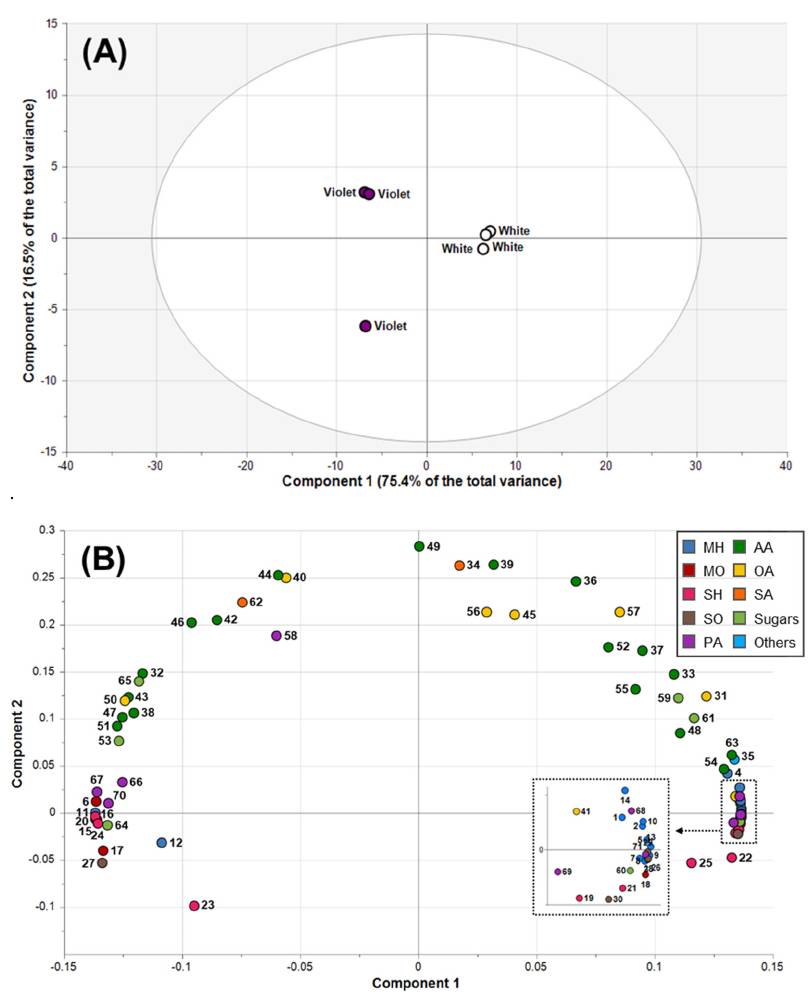
Figure 1. Score plots ( A ) and loading plots ( B ) of principal components 1 and 2 for the principal component analysis of essential oils, phenolic acids, and hydrophilic metabolites measured from M. heptapeta (white) and M. denudata var. purpurascens (violet) flower buds. MH, monoterpene hydrocarbons; MO, oxygenated monoterpene; SH, sesquiterpene hydrocarbons; SO, oxygenated sesquiterpene; PA, phenolic acids; AA, amino acids; OA, organic acids; SA, sugar alcohols. Plot annotations: 1, α -thujene; 2, α -pinene; 3, camphene; 4, sabinene; 5, β -pinene; 6, β -myrcene; 7, α -phellandrene; 8, δ -3-carene; 9, α -terpinene; 10, limonene; 11, 1,8-cineole; 12, ( Z )- β -ocimene; 13, γ -terpinene; 14, α -terpinolene; 15, camphor; 16, 3-cyclohexen-1-ol; 17, 3-cyclohexene-1-methanol; 18, borneol acetate; 19, α -copaene; 20, β -elemene; 21, β -caryophyllene; 22, α -humulene; 23, germacrene D; 24, α -muurolene; 25, δ -cadinene; 26, elemol; 27, trans-nerolidol; 28, β -eudesmol; 29, α -eudesmol; 30, α -cadinol; 31, glycolic acid; 32, alanine; 33, valine; 34, glycerol; 35, phosphoric acid; 36, leucine; 37, isoleucine; 38, proline; 39, glycine; 40, succinic acid; 41, fumaric acid; 42, serine; 43, threonine; 44, β -alanine; 45, malic acid; 46, aspartic acid; 47, methionine; 48, pyroglutamic acid; 49, γ -aminobutyric acid; 50, threonic acid; 51, glutamic acid; 52, phenylalanine; 53, xylose; 54, asparagine; 55, glutamine; 56, shikimic acid; 57, citric acid; 58, quinic acid; 59, fructose; 60, galactose; 61, glucose; 62, inositol; 63, tryptophan; 64, sucrose; 65, raffinose; 66, chlorogenic acid; 67, caffeic acid; 68, coumaric acid; 69, rutin; 70, ferulic acid; 71, cinnamic